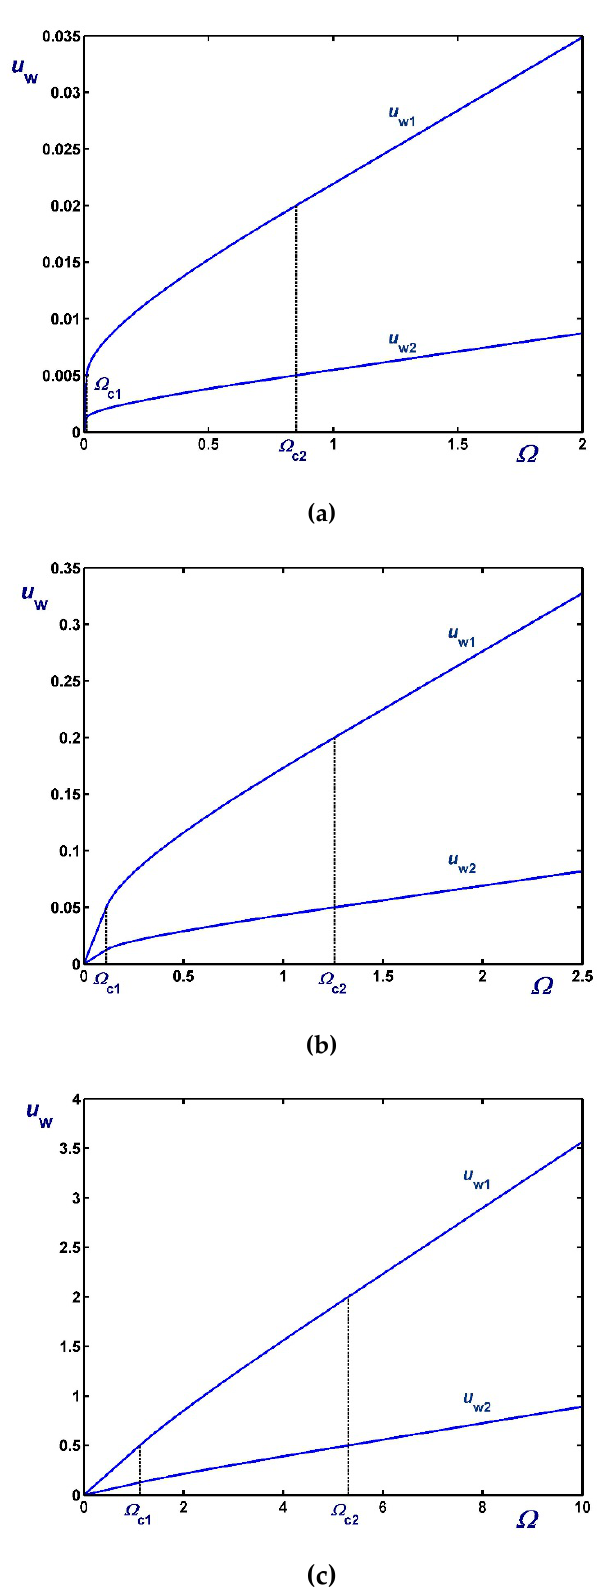
κ= 0.01 B B = = Figure 5. Slip velocities for κ = 0.5 and Navier slip along both cylinders: ( a ) B 1 = B 2 = 0.01 (weak slip); Figure 5. Slip velocities for 0.5 and Navier slip along both cylinders: ( a ) 1 2 ( b ) B 1 = B 2 = 0.1 (moderate slip); ( c ) B 1 = B 2 = 1 (strong (weak slip); ( b ) (strong slip). 1 2